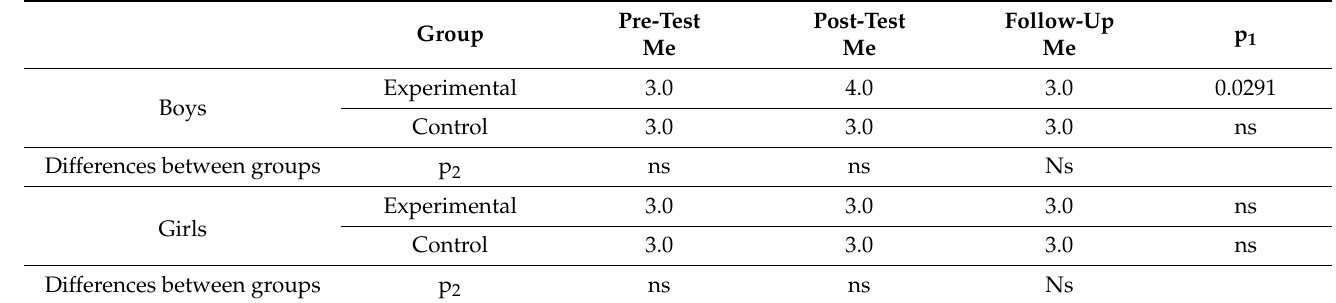
Table 2. Comparison of the values (median) of outdoor activity with Friedman’s ANOVA and within the genders (with Mann–Whitney U ) in the examined 7-year-old